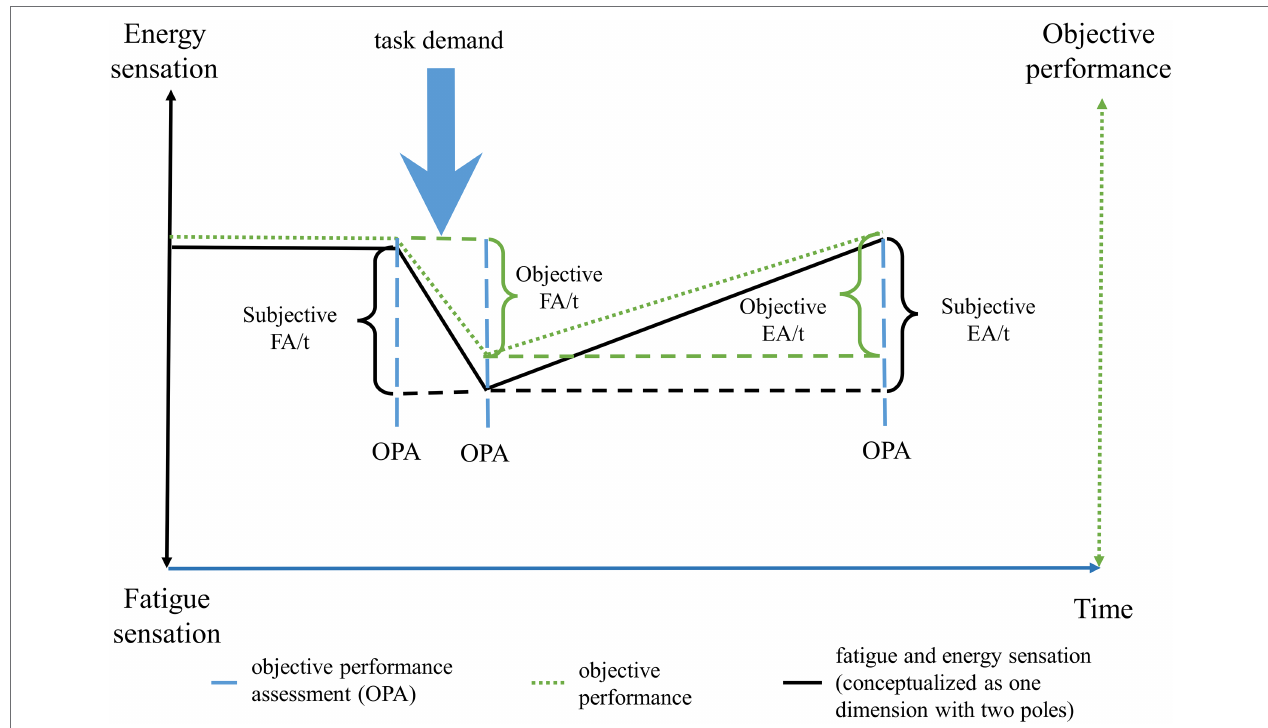
FIGURE 2 | The change over time of fatigue and energy sensations, and of objective energy levels following a cognitive/physical/emotional demand. The black solid line corresponds to the subjective changes over time, while the green dotted line to the objective changes over time. To calculate the changes in objective performance, an assessment is done at the time points where the dashed blue lines are. Note that the subjective changes may not always reflect the objective changes in energy levels, as is evidenced by the slightly courses of the black and green lines. FA, fatigability; EA, energizability; OPA, objective performance assessment; and t,